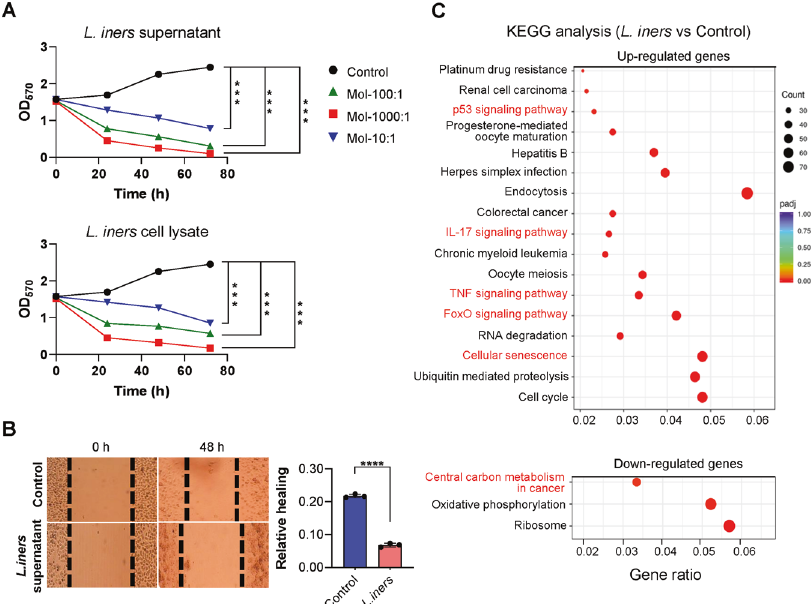
Fig. 4 The effect of L. iners metabolites on the proliferation and migration of cervical cancer cells. A MTT assay in SiHa cells stimulated with L. iners metabolites and bacterial lysates. B Scratch assay in SiHa cells stimulated with L. iners metabolites. *** p < 0.001, **** p < 0.0001. C KEGG pathways enriched in differentially expressed genes after the treatment of cervical cancer cells with L. iners